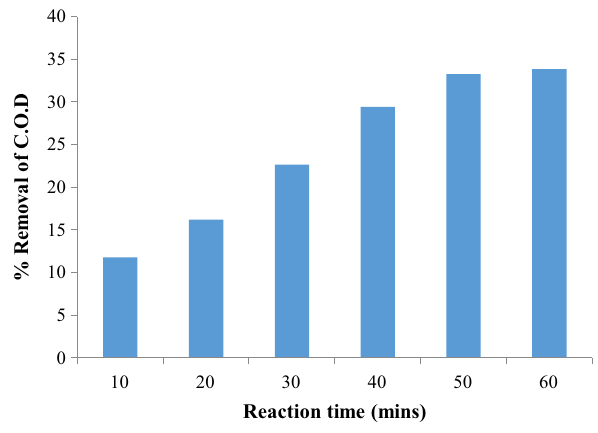
Fig. 8 Percentage removal of C.O.D after combined coagulation, Fenton and electro oxidation. Experimental conditions: working vol- ume = 250 ml; electrode material = SS–SS, electrode distance = 1 cm, reaction time = 10, 20, 30, 40, 50 and 60 min, initial pH = 7, electrode active surface area = 40 cm 2 , applied direct current voltage = 8 V, Current = 4–6 A, no. of electrodes = 2